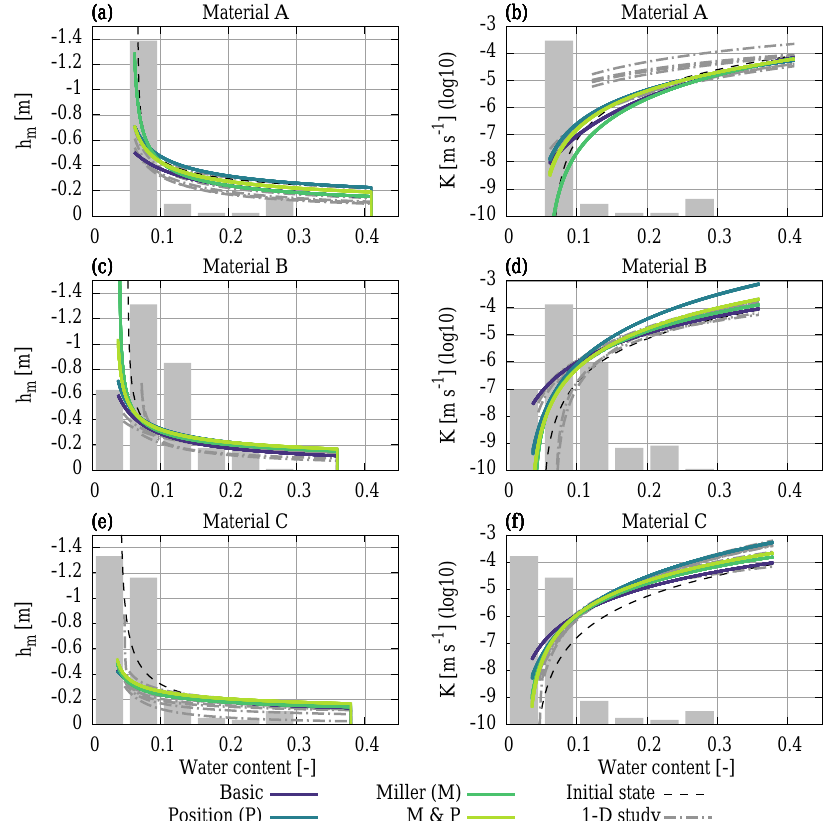
Figure 11. We show the resulting material functions for all three materials involved in the 2-D study which is analyzed with the four setups (basic, position, Miller, and Miller and position). The plot range is adjusted to the available water content range for each material. The height of the histogram bars denotes the number of available water content measurements and is normalized over all figures in this work. Since the inversions for all setups are initialized with the material functions resulting from the initial state estimation (Sect. A1.6), the difference between the results is directly linked to the estimation of sensor positions and small-scale heterogeneities. For direct comparison, the results of the 1-D study are also